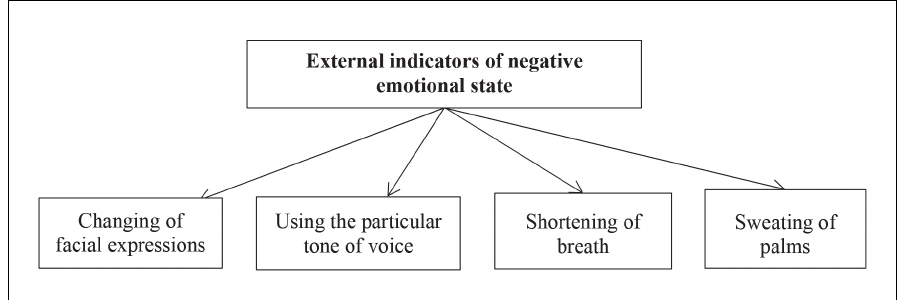
Figure 4. The main external indicators of negative emo - tional